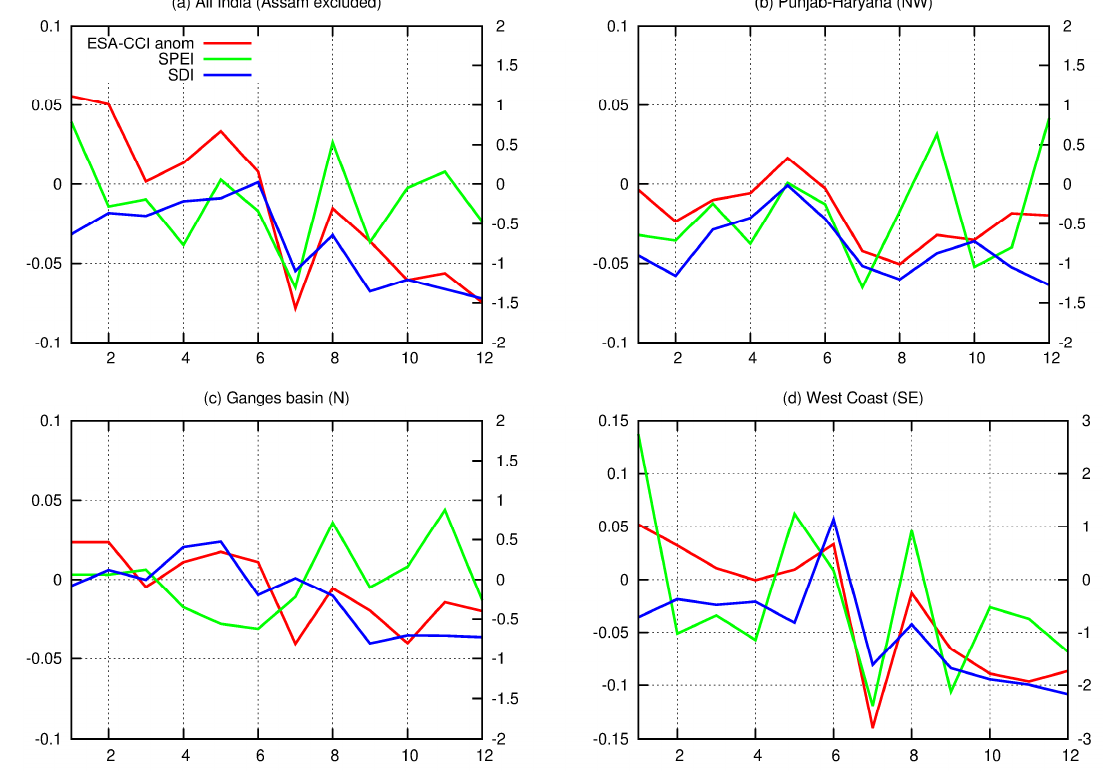
Figure 9. Monthly anomalies in 2002 of the indicators averaged on sub-regions highlighted in Figures 2 and 5, weighted by the total rice harvested area.